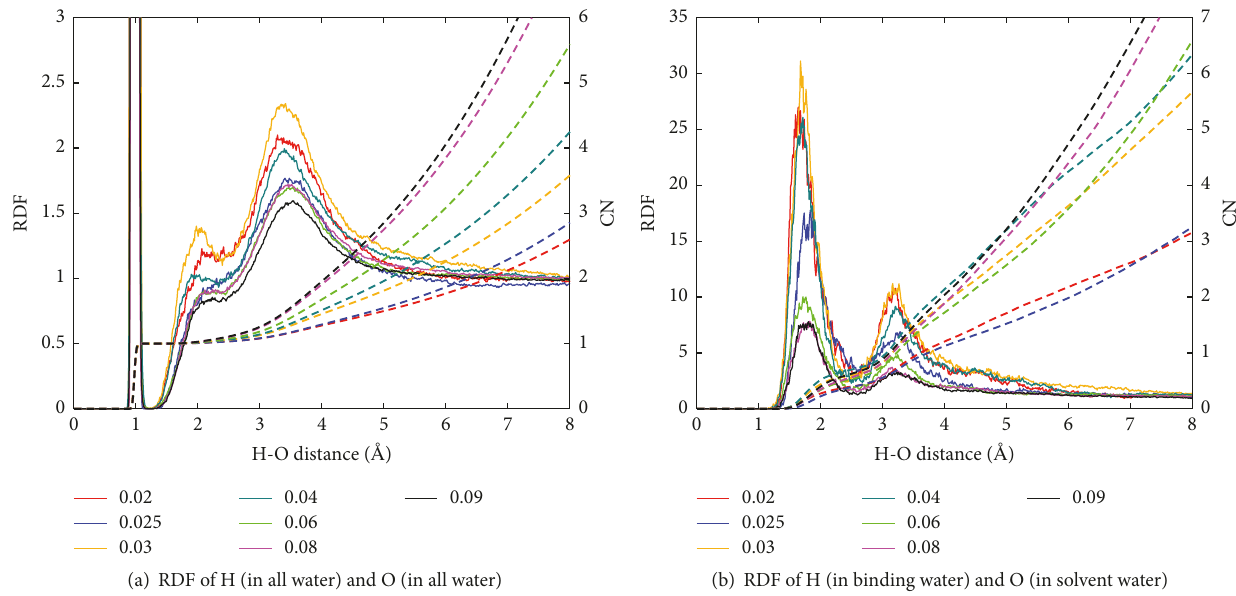
Figure 4: H-O radial distribution function (RDF, solid lines, left axes) and the coordination number (CN, dashed lines, right axes) versus the H-O distance. (a) shows the RDF of all H with all O atoms in the simulation; (b) shows the RDF of H in the [CuCl(H 2 O)] 0 cluster with O in the solvent water (excluding the water molecule in the [CuCl(H 2 O)] 0 cluster).